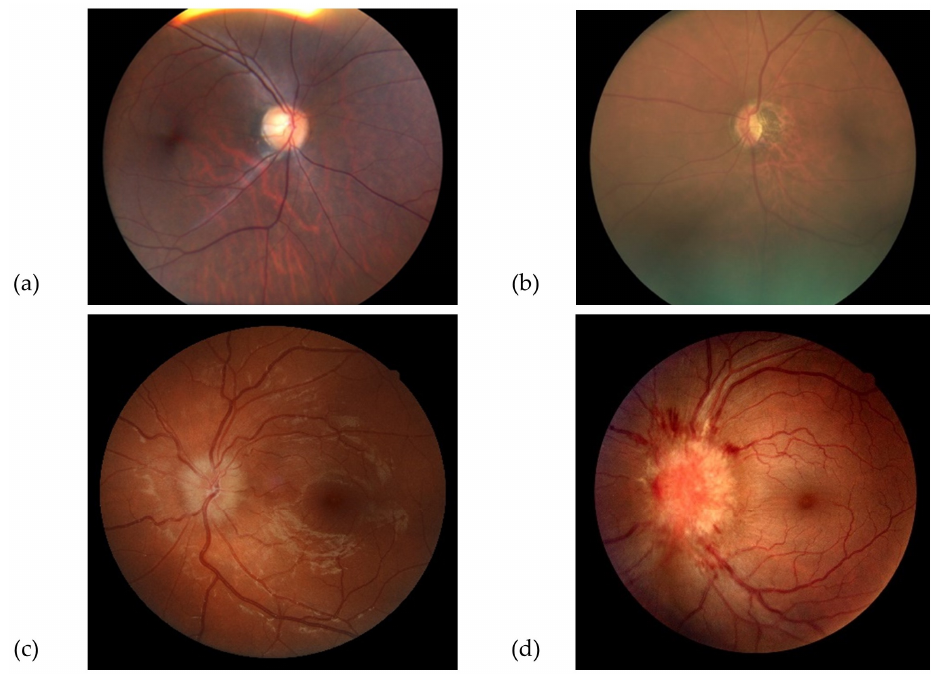
Figure 1. Examples of “good” quality colour fundus photographs of normal optic discs and discs with papilledema, acquired with handheld cameras ( a , b ) and desktop cameras ( c , d ).